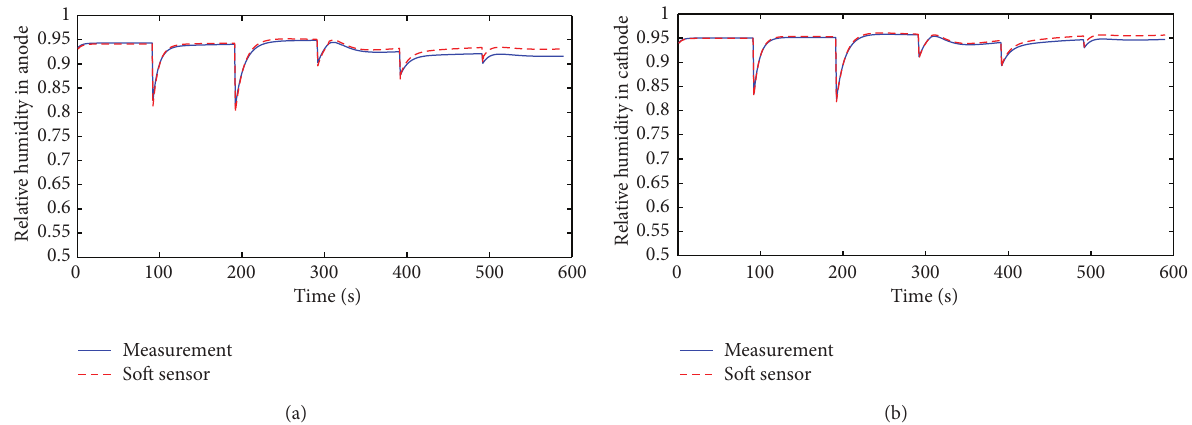
Figure 12: Comparison of measured and soft sensor’s relative humidity in the speed-up condition when relative humidity of cathode is set as 0.95. (a) Anode; (b) cathode.